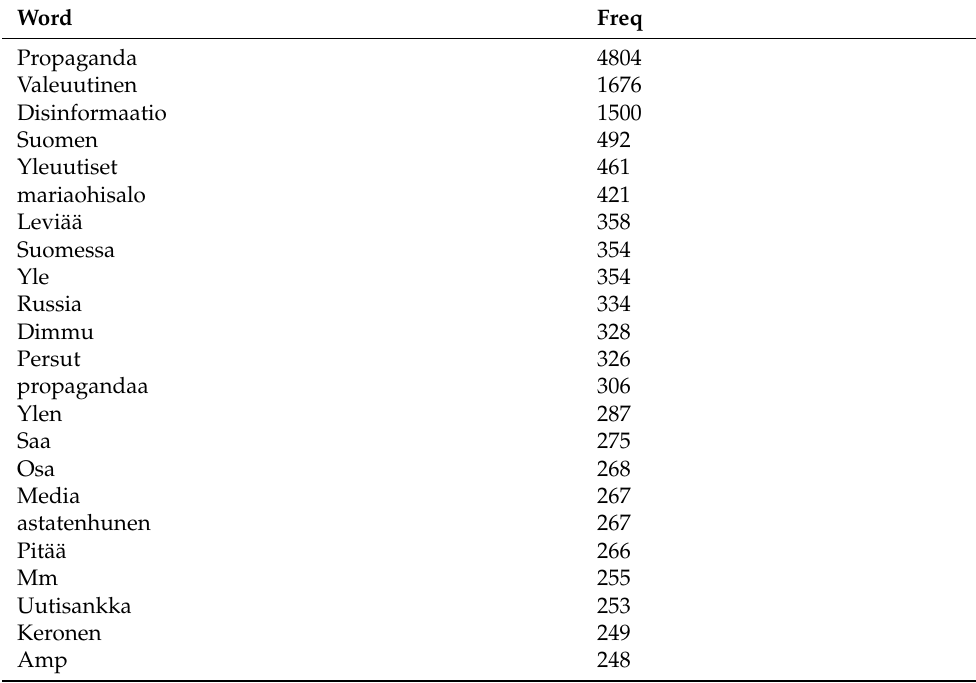
Table 4. Top 30 most frequent words in tweets.